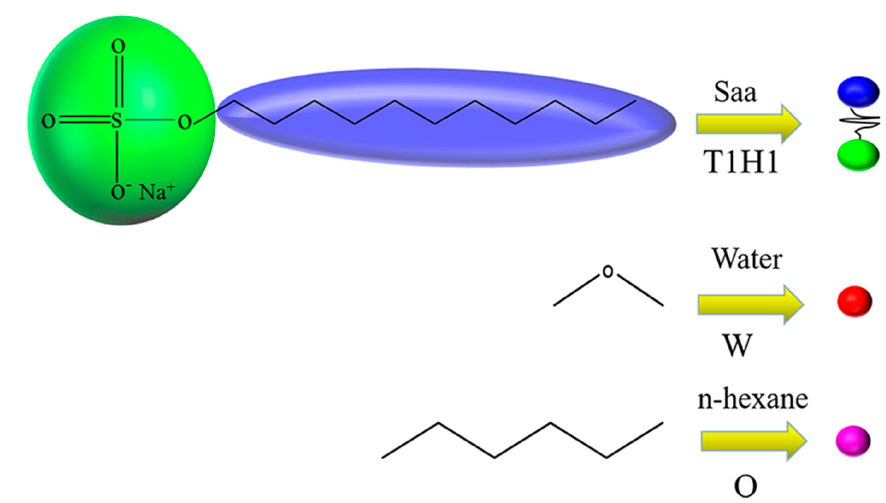
Figure 1. A coarse-grained model for surfactant, water and oil. Figure 1. A coarse ‐ grained model for surfactant, water and oil.